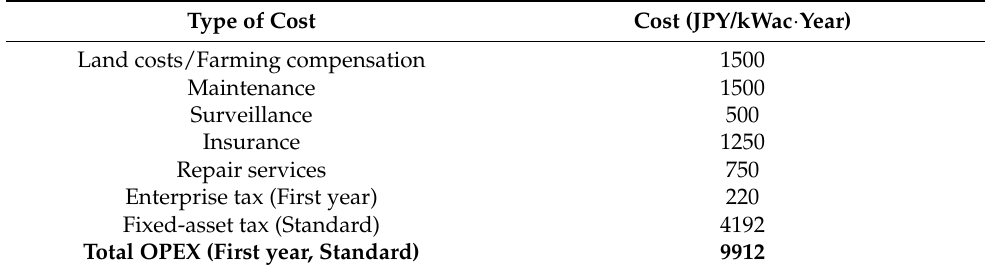
Table 6. OPEX of each cost factor in JPY/kWac year for